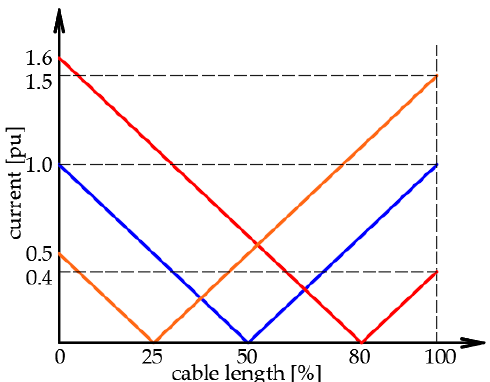
Figure 3. Cable screen current under no-load conditions as a function of cable length; orange represents open-phase in cable screen in 25% of cable length, blue represents ideal cable, and red represents open-phase in cable screen in 80% of cable length.